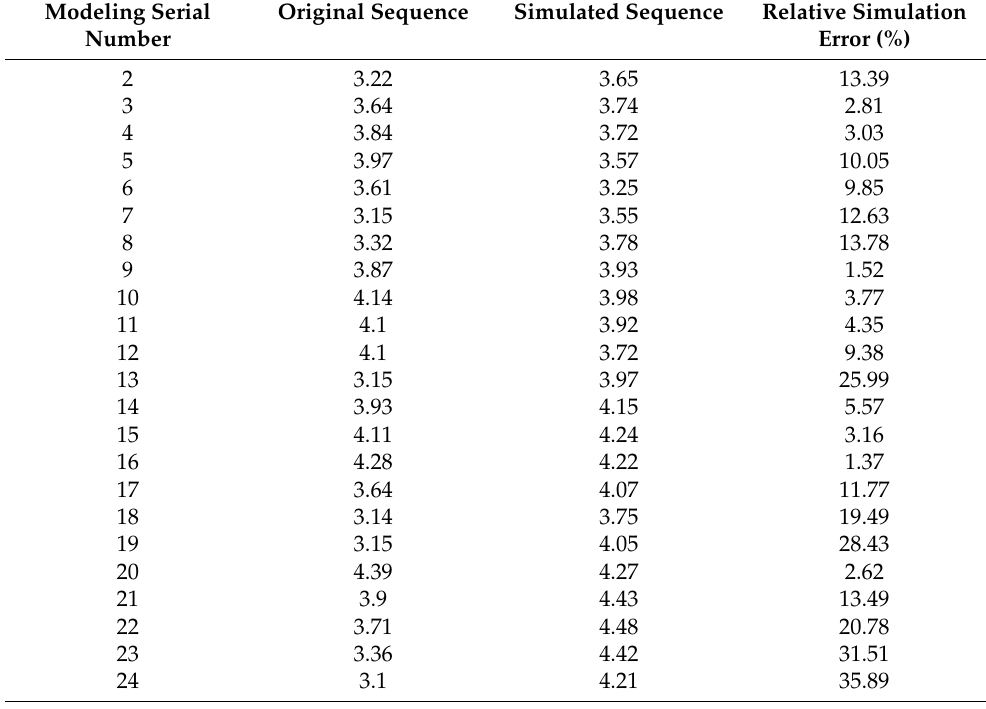
Table 5. Error of absolute dry flexural strength simulation results.